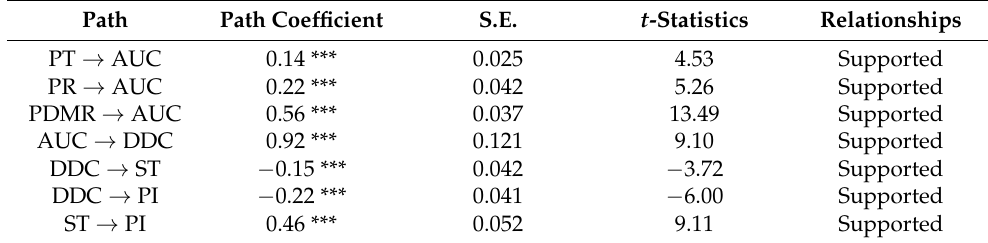
Table 4. Results of the direct effects.